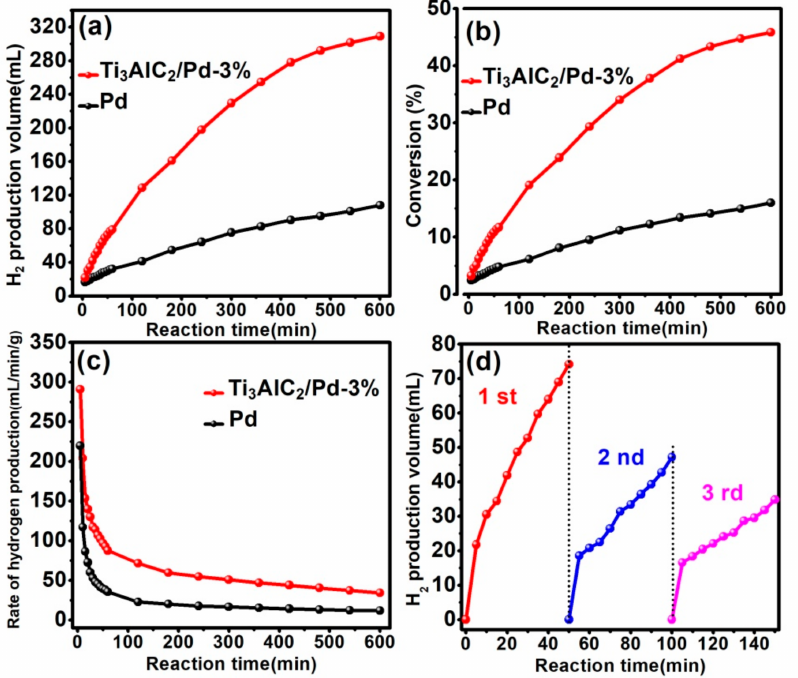
Figure 5. Comparison of the hydrogen generation over Ti 3 AlC 2 /Pd-3% and Pd nanoparticles: ( a ) Hydrogen production in 600 min. ( b ) Conversion rate of formaldehyde in 600 min. ( c ) Hydrogen production rate in 600 min. ( d ) Hydrogen production performance within three cycles. Reaction condition: catalyst: 15 mg, NaOH: 1 M, HCHO: 0.6 M, temperature: 25 ◦ C.